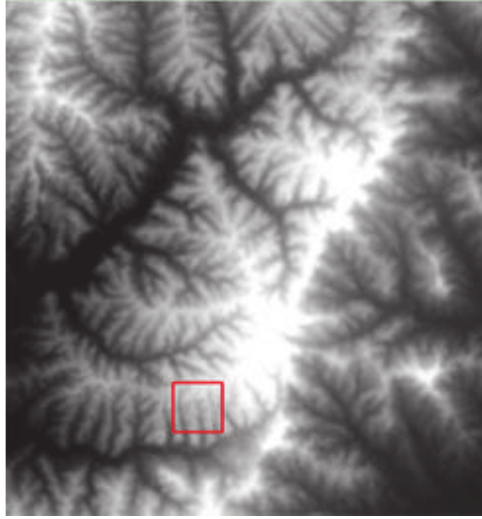
Figure 11: Topography file in TIF of some